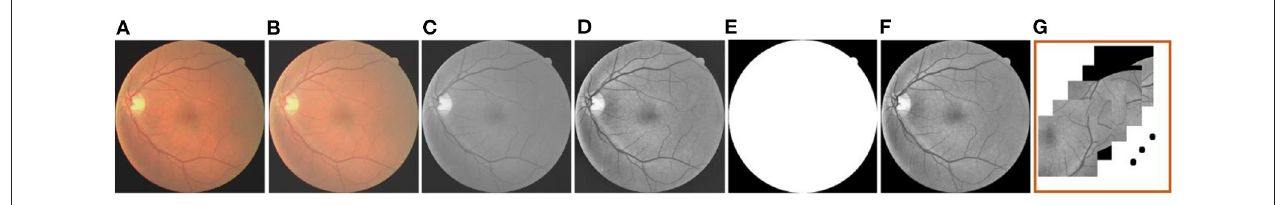
FIGURE 2 | The preprocessing operation: (A) Original image; (B) Gamma-corrected image; (C) Green channel image; (D) CLAHE image; (E) Mask; (F) Mask-processed image; and (G)